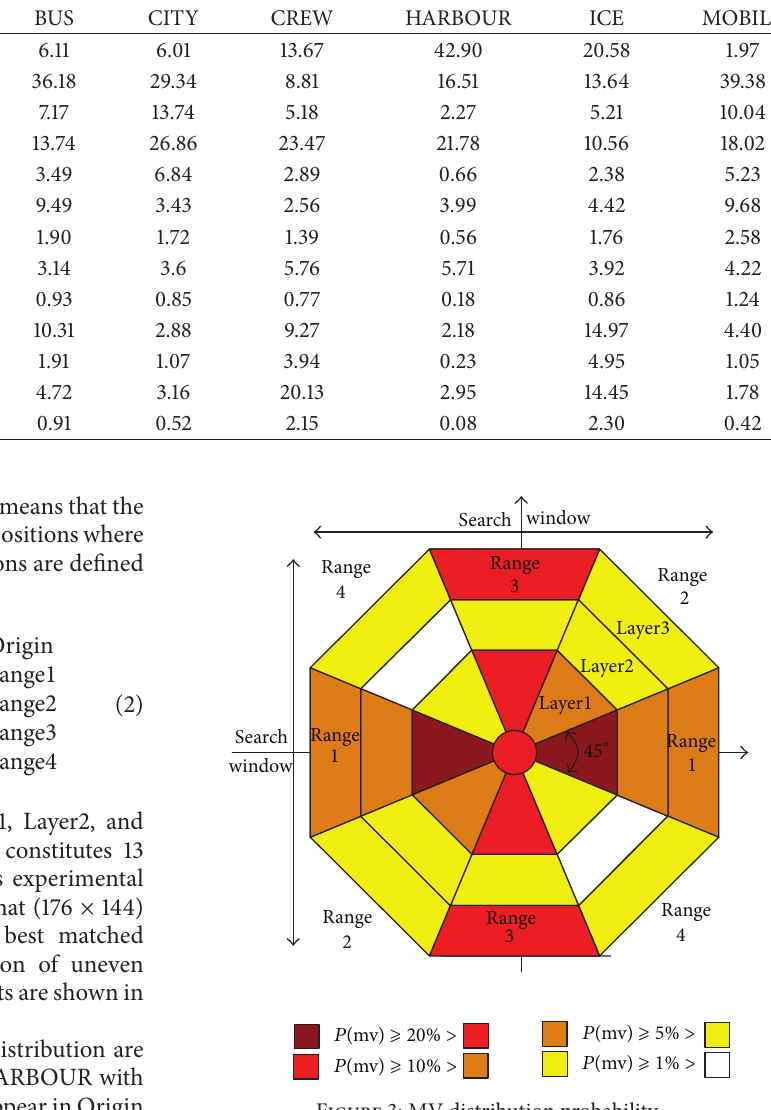
Figure 3: MV distribution